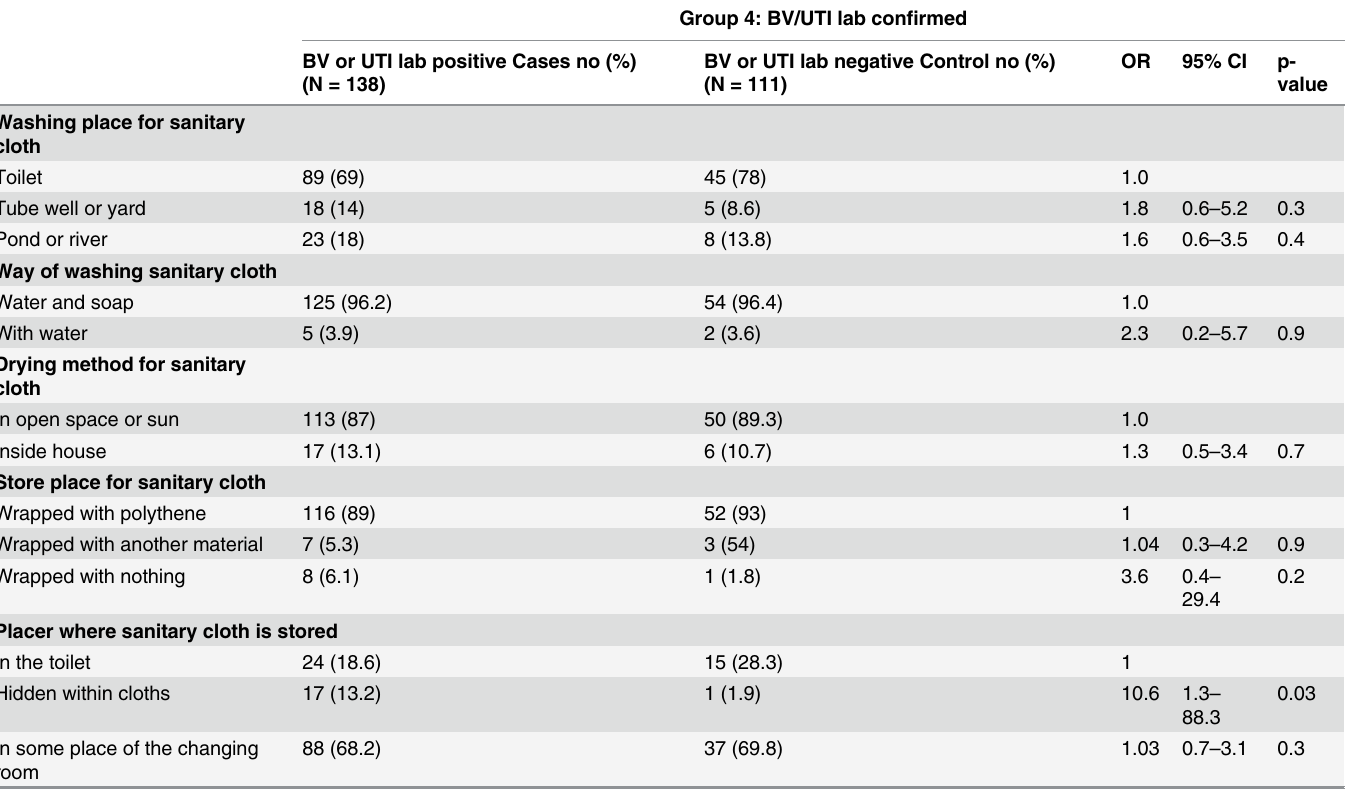
Table 4. Univariate analysis among women who use reusable cloth pads (N = 249) comparing the odds of different MHM practices for washing, drying and storing cloth pads among BV or UTI laboratory confirmed cases and BV or UTI laboratory negative controls (excluding symptomatic controls) (Group